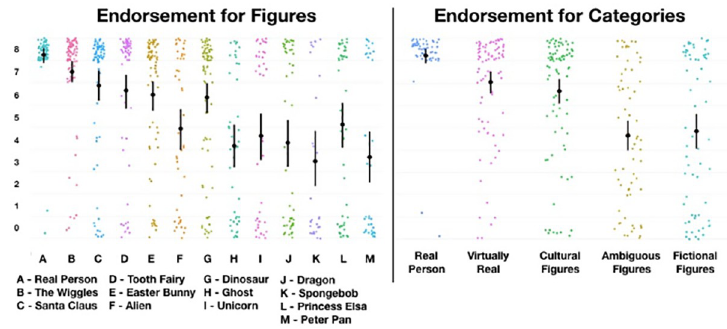
Fig 3. Childrens endorsement scores for individual figures and